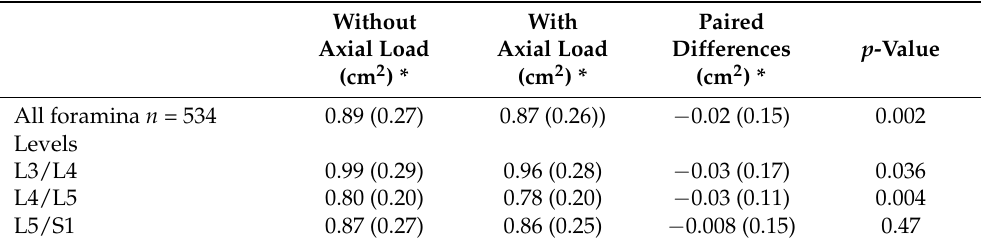
Table 2. Comparison of the foraminal area with and without axial spinal loading for all measured foramina, stratified for lumbar